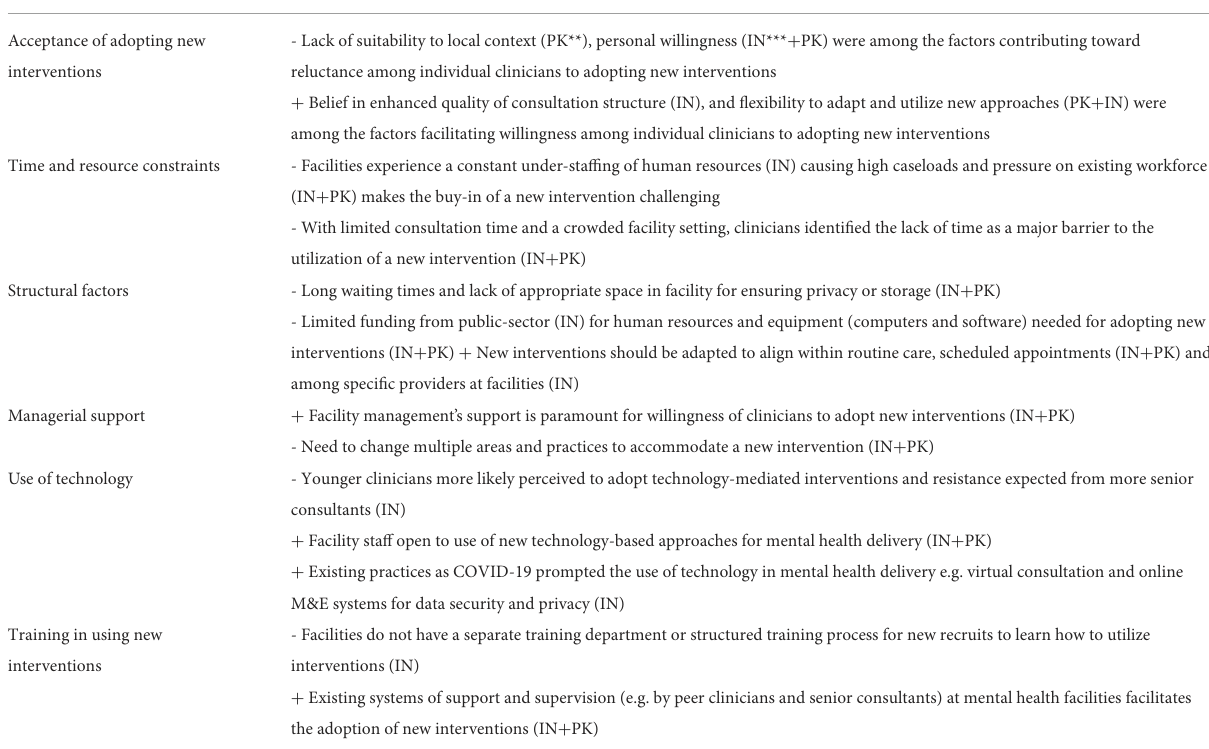
TABLE 5 Key findings from healthcare workers on barriers and facilitators to the adoption of a new intervention at mental health facilities in India and Pakistan. Themes Key findings across